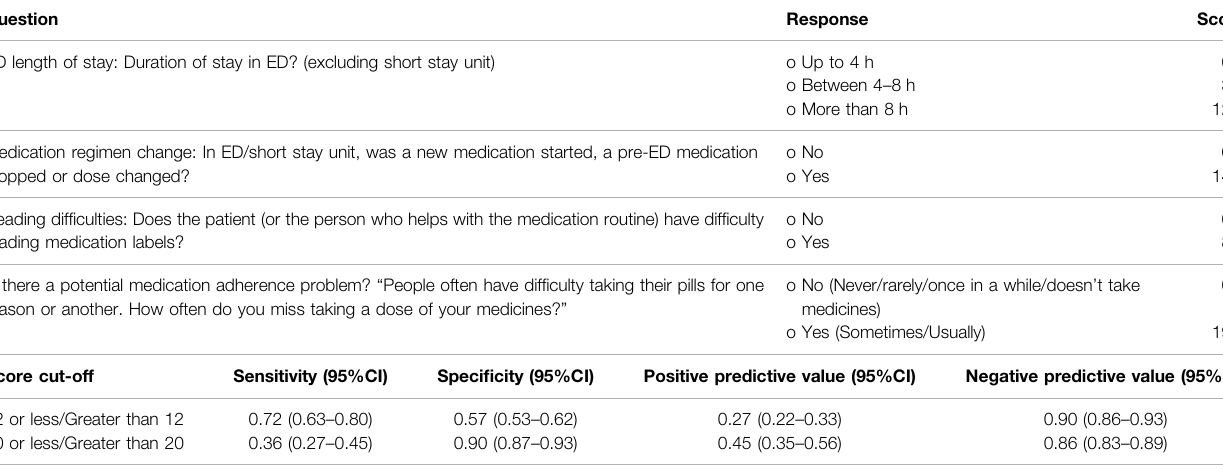
TABLE 5 | ED Discharge medication-related problem screening